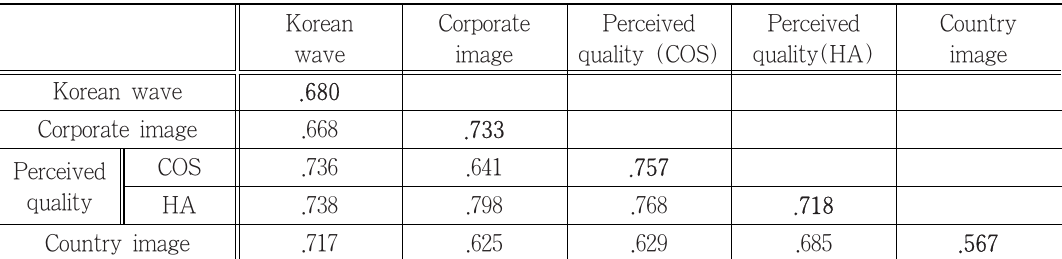
<Table 2> Results of discriminant validity